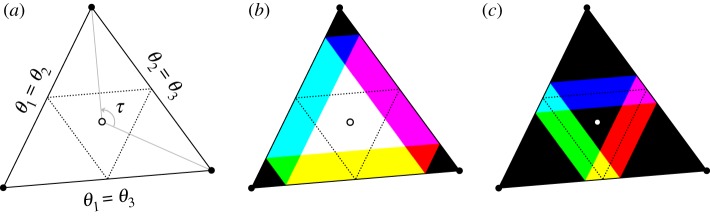
The sets Θg(H) for different H partition the canonical invariant region C for the fully symmetric system of N = 3 oscillators. The CIR is sketched in (a): its boundary is given by the sets θ1 − θ2 = 0, θ2 − θ3 = 0 and θ3 − θ1 = 0 (black lines) which intersect in Θsync (black dot, •). The splay phase Θsplay is the centroid (hollow dot, °) and is the fixed point of the residual Z3=⟨τ⟩ symmetry which rotates the CIR (indicated by grey lines). Dashed lines indicate phase configurations where one phase difference is equal to π. For a dead zone symmetric coupling function g∈F(1) only the undirected subgraphs of K3 can be realized; these correspond to the ones shown in figure 4 excluding the cycles. (b) The partition of the CIR for DZ(g) = (π/3, 5π/3). (c) The partition for a dead zone symmetric coupling function with DZ(g) = (5π/6, 7π/6). (Online version in colour.)